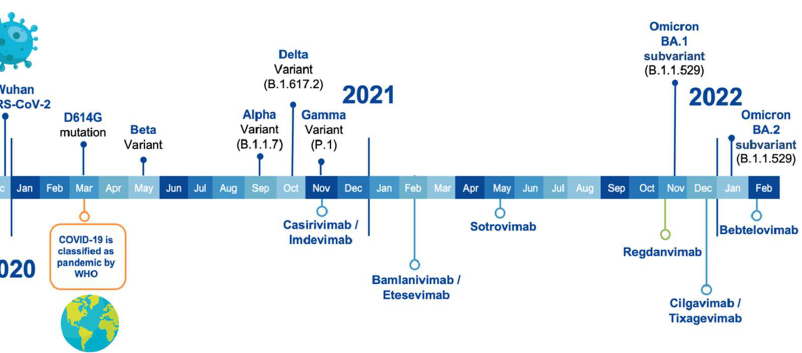
Figure 1. Timeline of SARS-CoV-2 VOCs emergence (on top of the time bar) along with the first EUA by the FDA and/or EMA of the therapeutic antibodies (underneath the time bar).